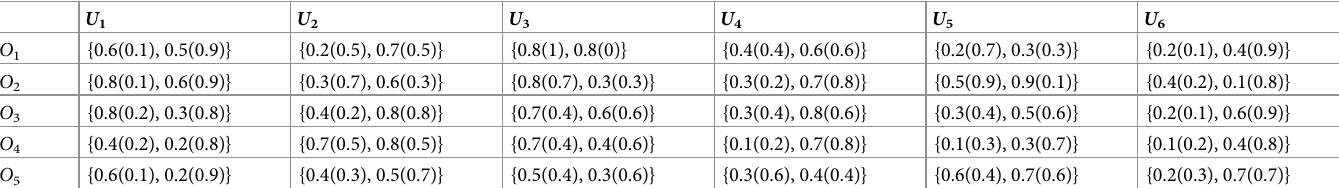
Table 6. Normalize PHF matrix Y 3 given by the third